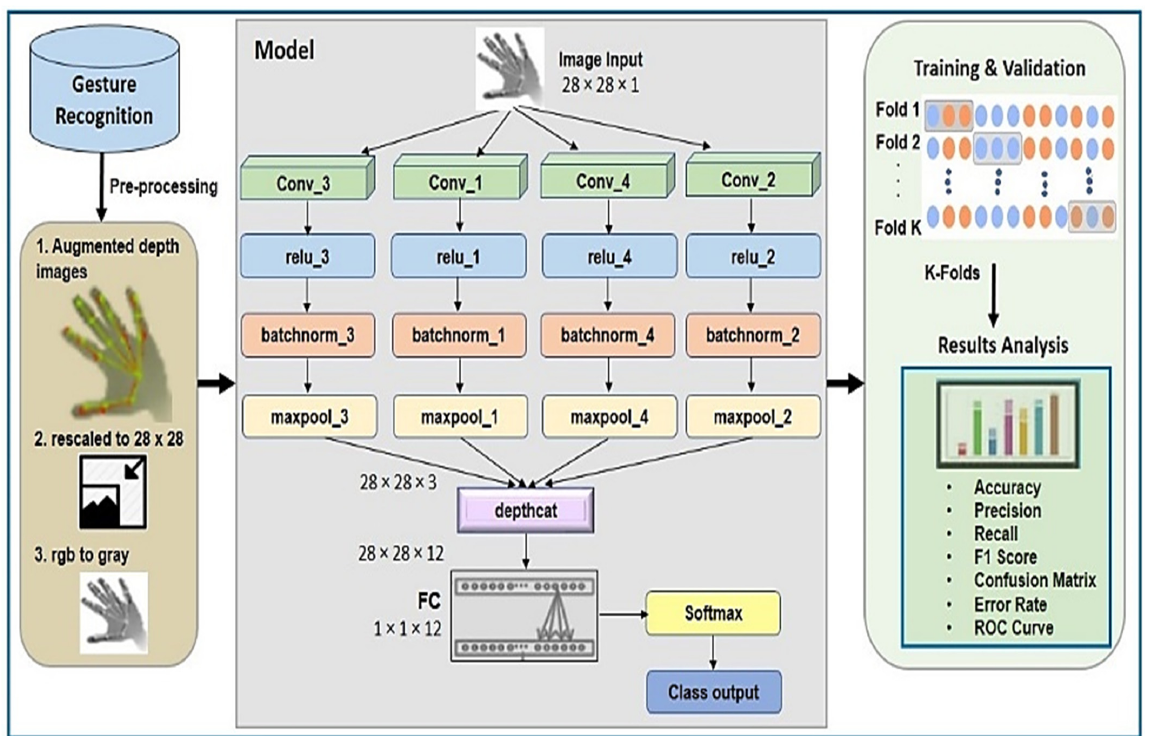
Figure 2. Proposed methodology. Table 3. Network architecture details.